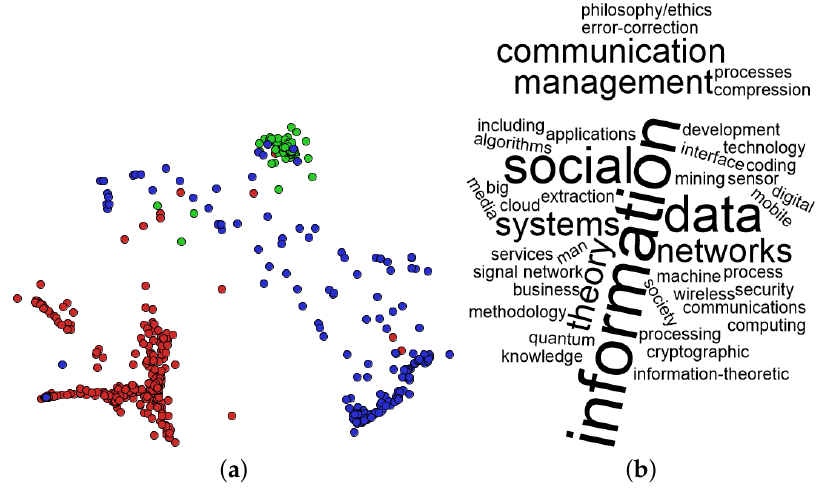
Figure 1. Example of visualization techniques: ( a ) a graphical representation generated with a multidimensional projection technique from a textual dataset of scientific papers; and ( b ) a graphical representation generated with tag cloud